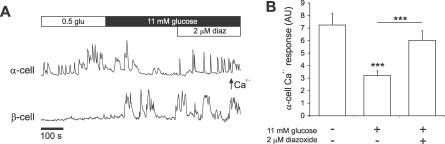
The Intracellular Ca2+ Response of Single α Cells within Intact Islets Can Be Re-Activated by Low Concentrations of Diazoxide(A) Representative intracellular Ca2+ responses from α and β cells within an intact mouse islet exposed to 0.5 mM glucose, 11 mM glucose, and 11 mM glucose plus 2 μM diazoxide (diaz) as indicated above the traces.(B) The Ca2+ response of α cells was suppressed by 11 mM glucose, and could be reactivated with low concentrations of the KATP channel agonist diazoxide. ***, p < 0.001, compared with the low-glucose condition, or as indicated.